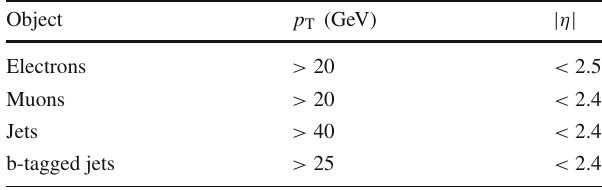
Table 2. The observed and predicted yields in the control and Table 1 Kinematic requirements for leptons and jets